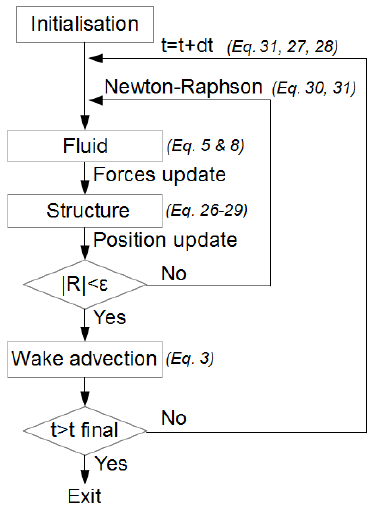
Fig. 4. Diagram of fluid-structure coupling algorithm with an implicit partitioned approach Further methods are used to ensure the convergence, such as the added mass implementation in the struc- ture code [13] and the Aitken adaptive relaxation